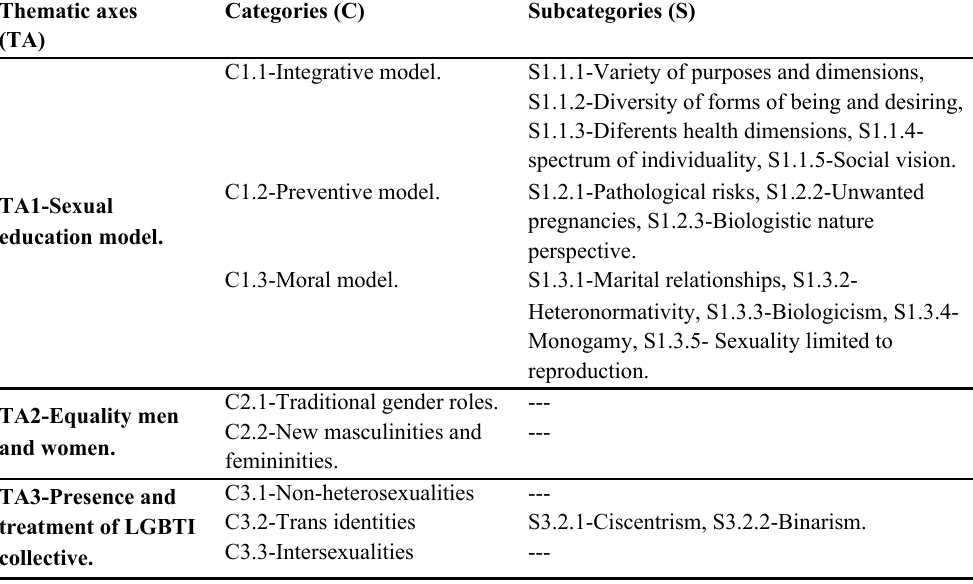
Table 2. Categories used for